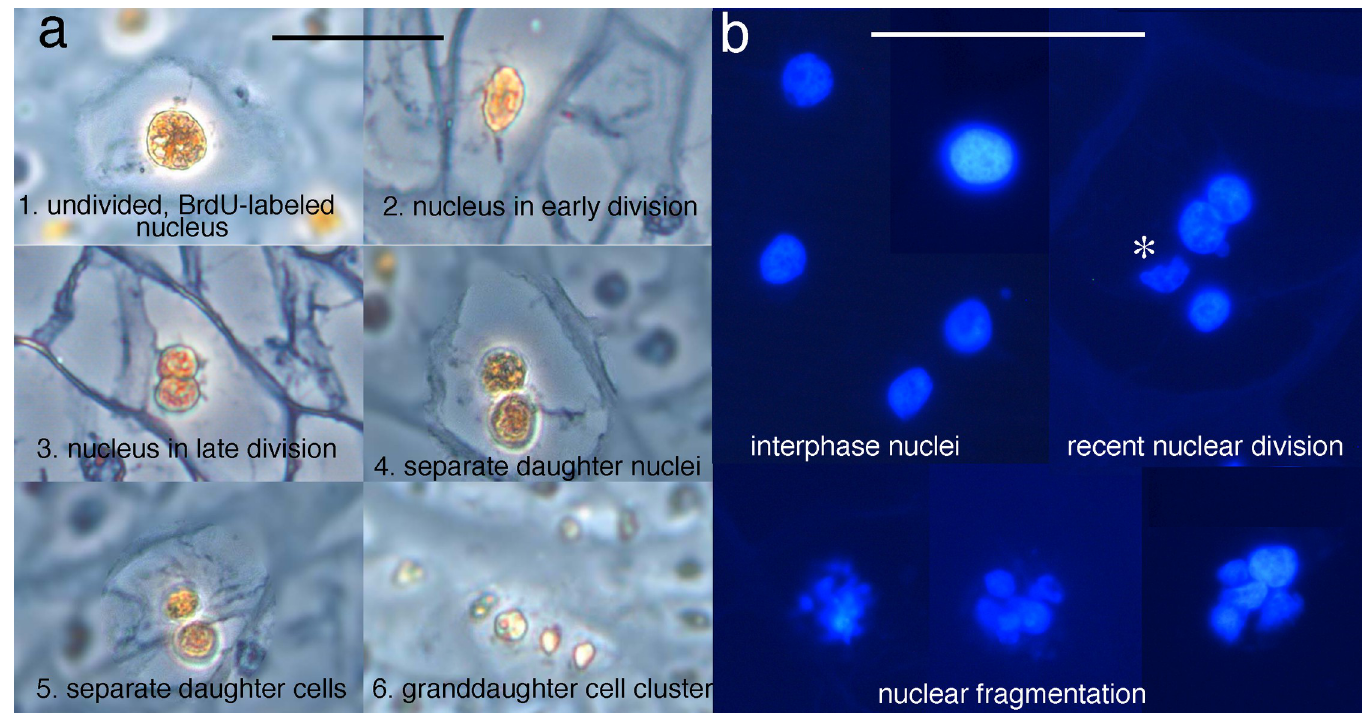
Fig 2. Criteria to score mitosis and nuclear fragmentation. (a) BrdU-pulsed chondrocytes at different stages of mitosis in phase micrographs. (b) DAPI-stained interphase nuclei, and nuclei showing signs of recent division and nuclear fragmentation in fluorescence micrographs. � indicates a nucleus that appears to have been fragmented by